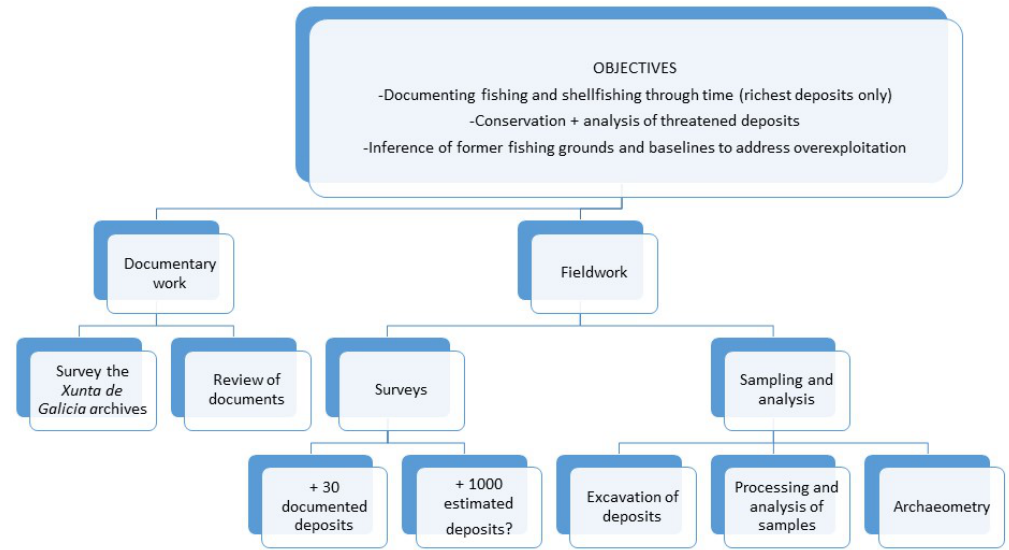
Figure 3. Flow chart of a working proposal for future action: The Middens’ Master